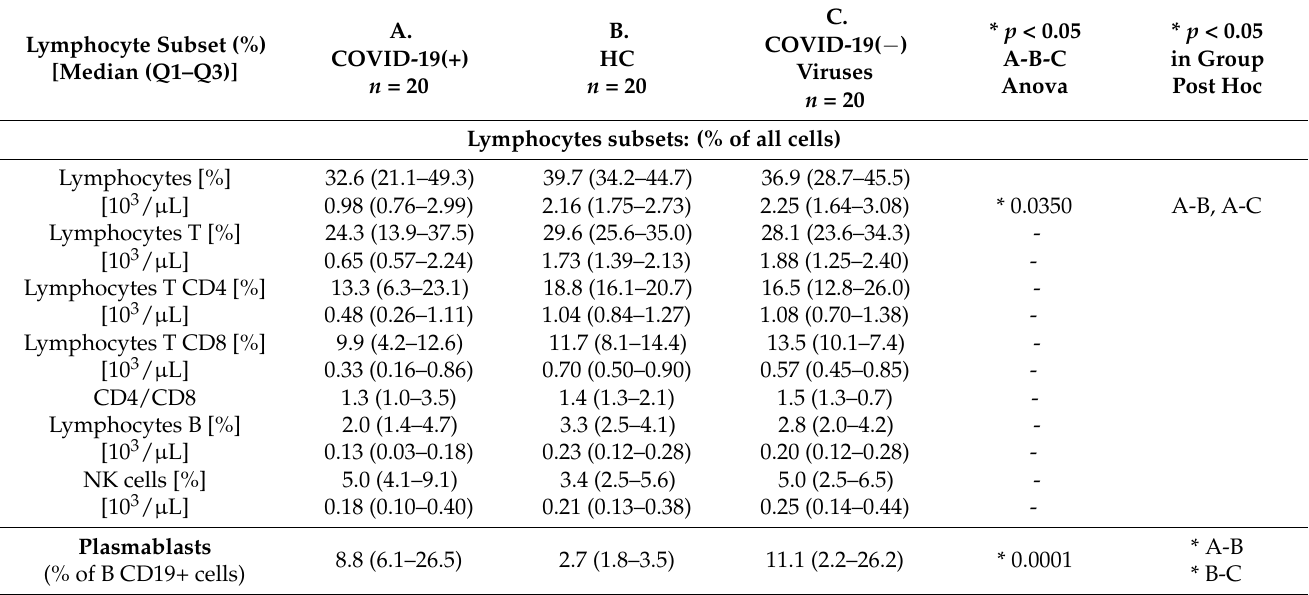
Table 3. Differences of basic lymphocyte subtypes and plasmablasts between patients: with positive COVID-19 test—group A, control group (HC)—group B and group with other virus infections with negative COVID-19 test—group C. Data expressed as median